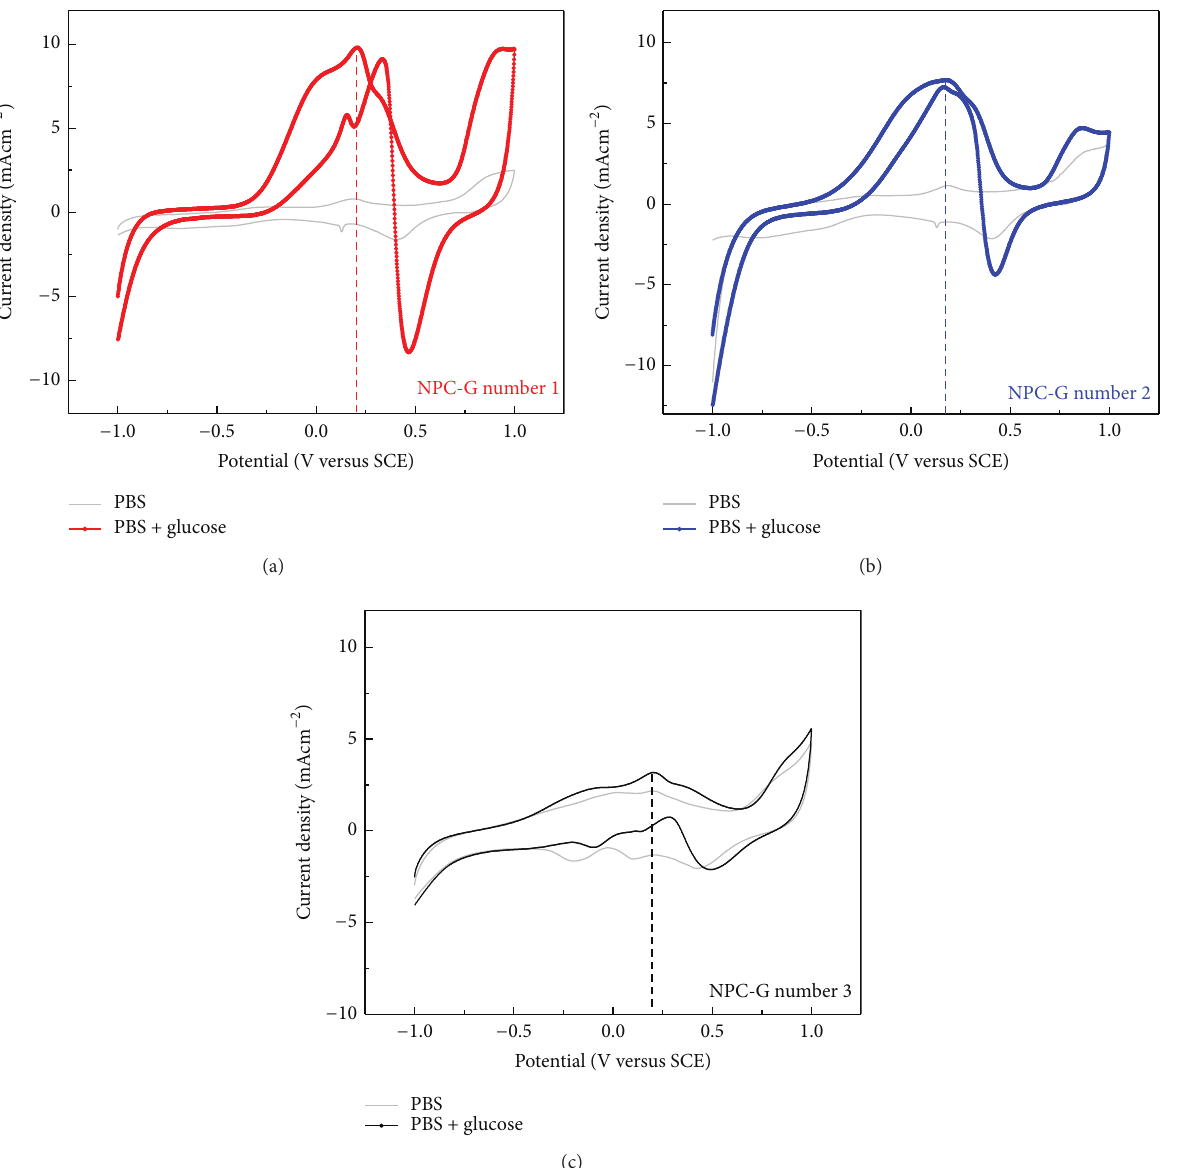
Figure 4: CV curves of the NPC-G samples in in 0.1mol/L KOH alkaline aqueous solutions with 50 mmol/L glucose, scan rate 0.05 V/min, versus